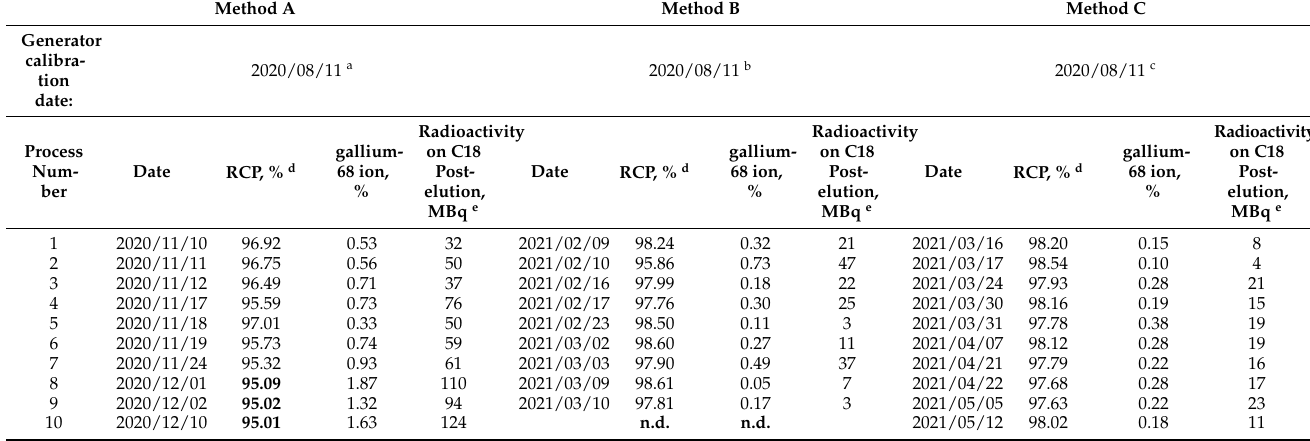
Table 3. Comparison of quality control data on [ 68 Ga]Ga-PSMA-11 preparations obtained using different methods to prepare the precursor